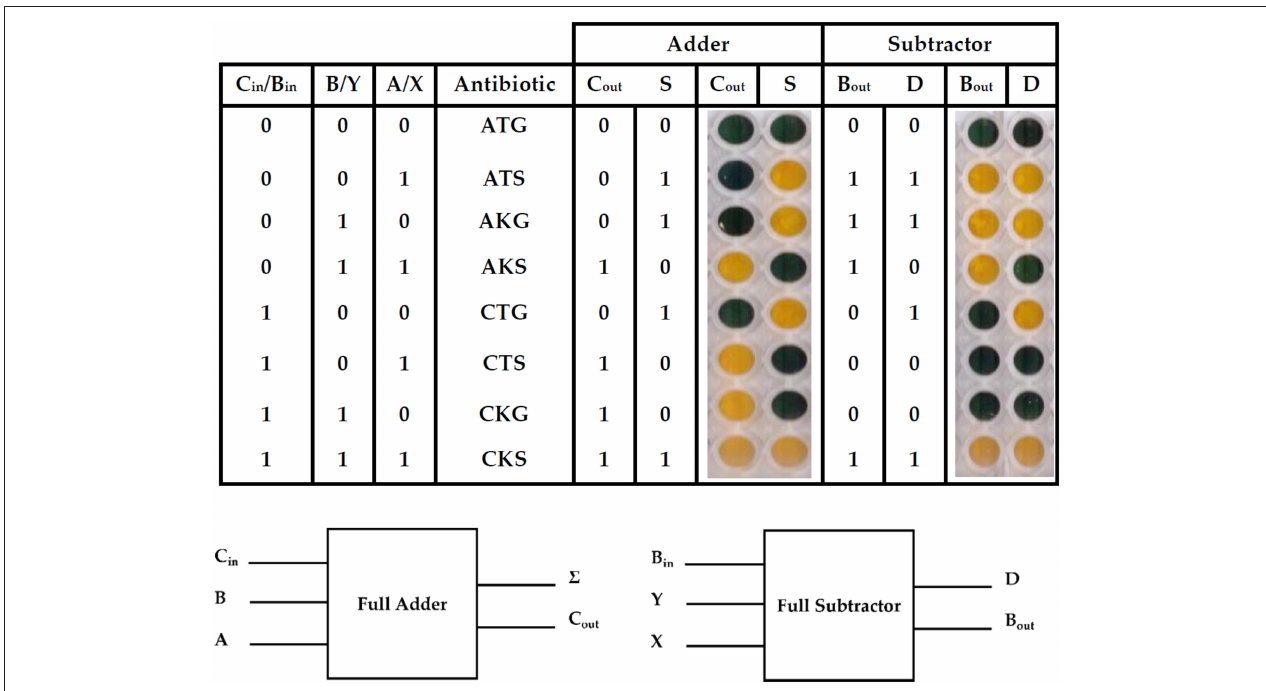
FIGURE 3 | Full adder and subtractor using the 3 bit ParAlleL system. The figure shows results of addition and subtraction using the ParAlleL for 3 bit system. Cells were mixed as shown in Figure S3 and inoculated (1:100) in LB supplemented with 1%w/v glucose. After 18 hours of incubation, the plate was developed by addition of the 0.05 volumes of developing